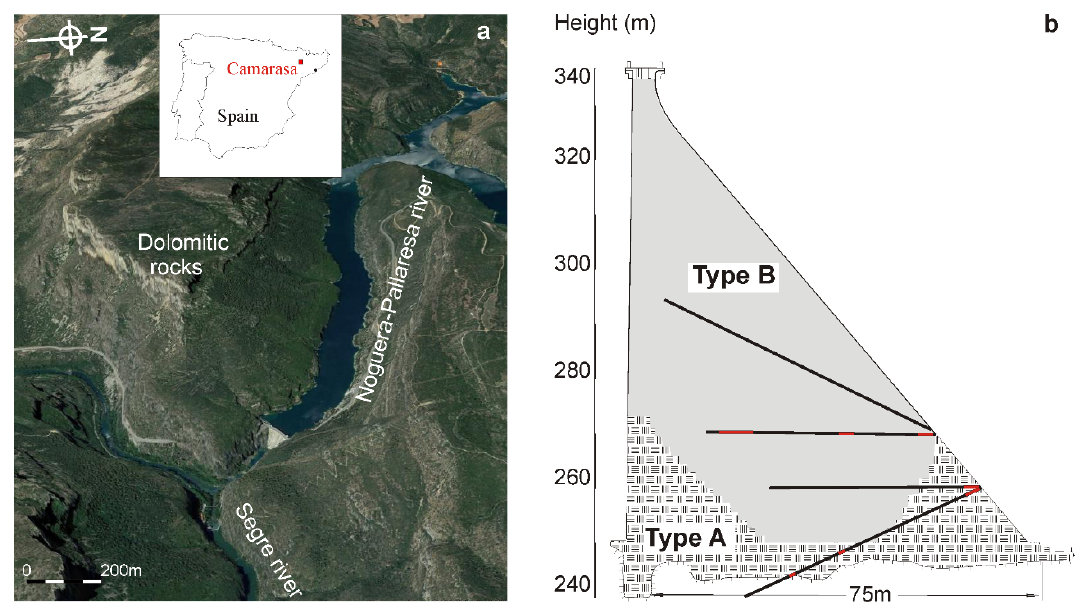
Figure 1. ( a ) View of the Camarasa Dam; ( b ), sketch with the distribution of the two concrete types (modified from [26] and the location of the cores (black lines) and samples (red)).